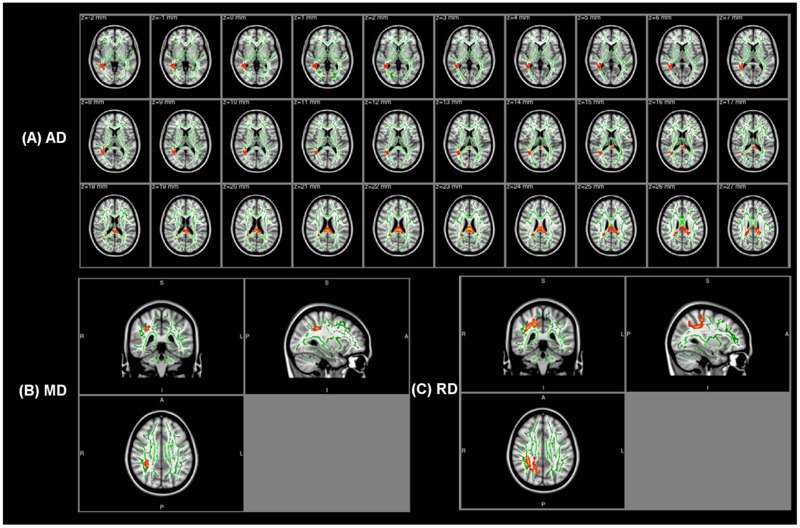
The white fiber tracts with higher AD/MD/RD values in the amusia group. (A) The white fiber tracts with higher AD values (p < 0.001, corrected for multiple comparisons). (B) The white fiber tracts with higher MD values (p < 0.001, corrected for multiple comparisons, MNI coordinate: 33, -36, 34). (C) The white fiber tracts with higher RD values (p < 0.006, corrected for multiple comparisons, MNI coordinate: 32, -38, 36). Background images: standard MNI_T1_1mm template and the mean FA skeleton (Green). Warm colors (Red–Yellow): the corresponding value increases in the amusia group. Clusters of significant voxels are projected on the background images using the tbss_fill script in FSL to make the visualization easy.